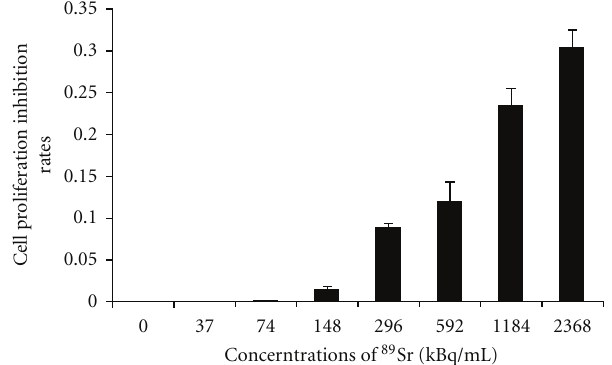
Figure 2: MCF-7 cell proliferation inhibition rate due to being induced by 89 Sr of various